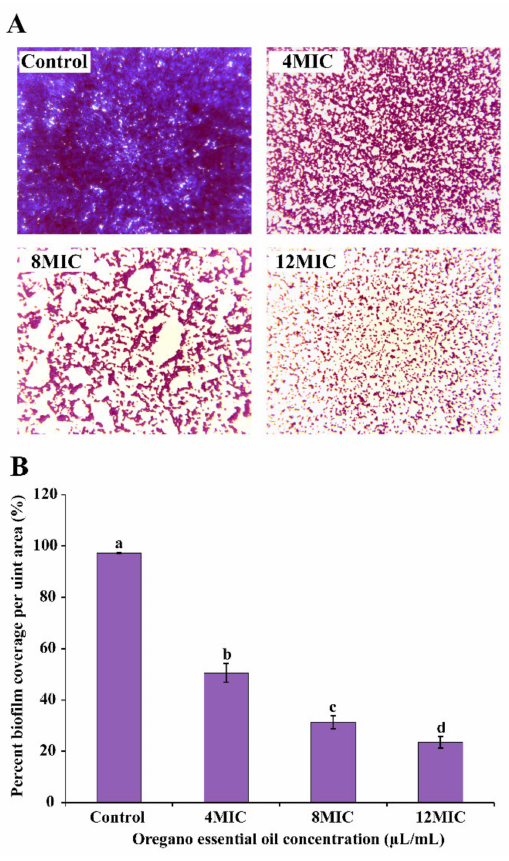
Figure 10. E. faecalis ATCC 29212 biofilms treated with varying doses of OEO as seen under a light microscope ( A ). Optical Microscope-Based Observation was used to calculate the percent biofilm coverage per unit area ( B ). Different lowercase letters indicate statistically significant differences between the means ( p < 0.05).